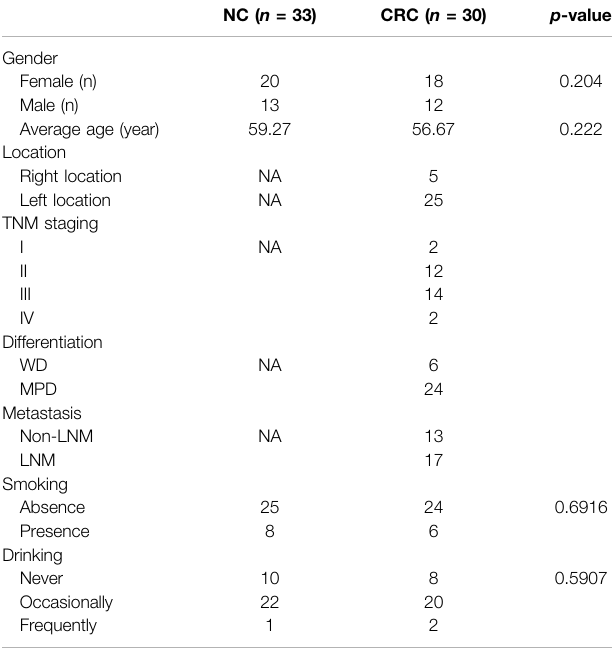
TABLE 1 | The basic characteristics of